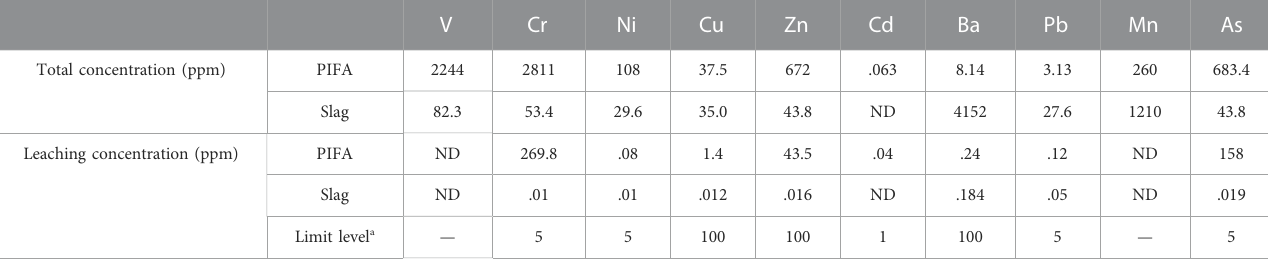
TABLE 3 Total concentration and leaching concentration of heavy metal contents of the PIFA and gasi fi cation slag.